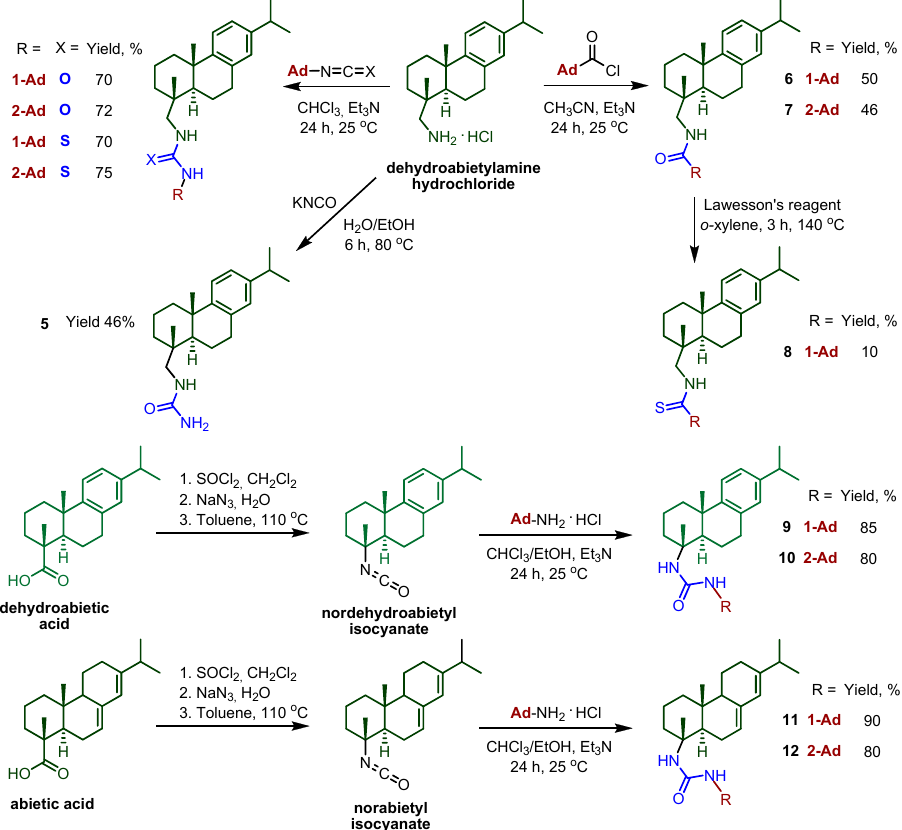
Scheme 1. General procedure for the synthesis of compounds 1 −